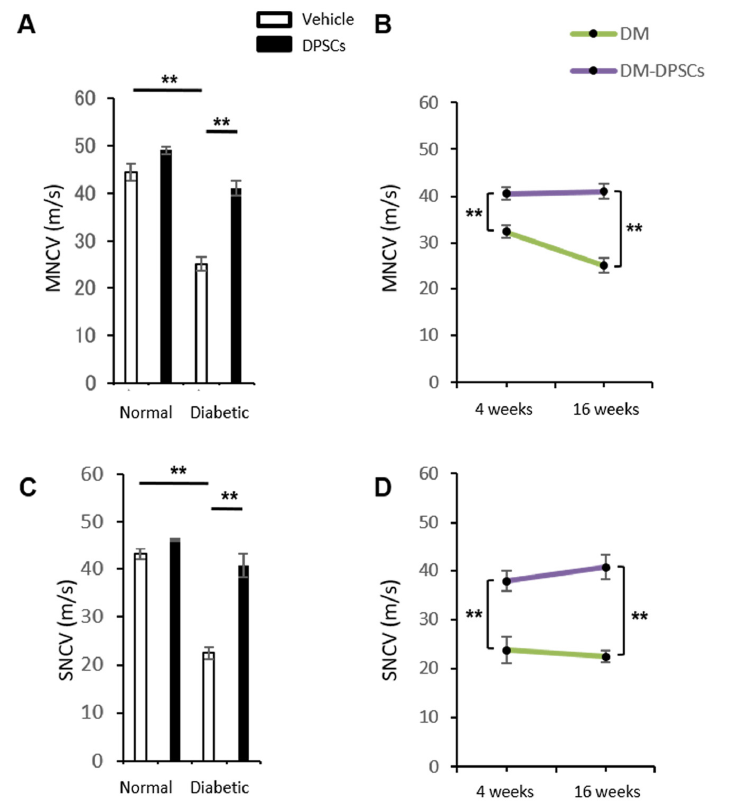
Figure 4. Nerve conduction velocity. ( A ) Sciatic motor nerve conduction velocity at 16 weeks after hDPSC transplantation. ( B ) Sciatic motor nerve conduction velocity at 4 and 16 weeks after hDPSC transplantation in diabetic mice. ( C ) Sciatic sensory nerve conduction velocity at 16 weeks after hDPSC transplantation. ( D ) Sciatic sensory nerve conduction velocity at 4 and 16 weeks after hDPSC transplantation in diabetic mice. The results are expressed as the mean ± SEM ( n = 4). ** p < 0.01. DM: diabetes mellitus.